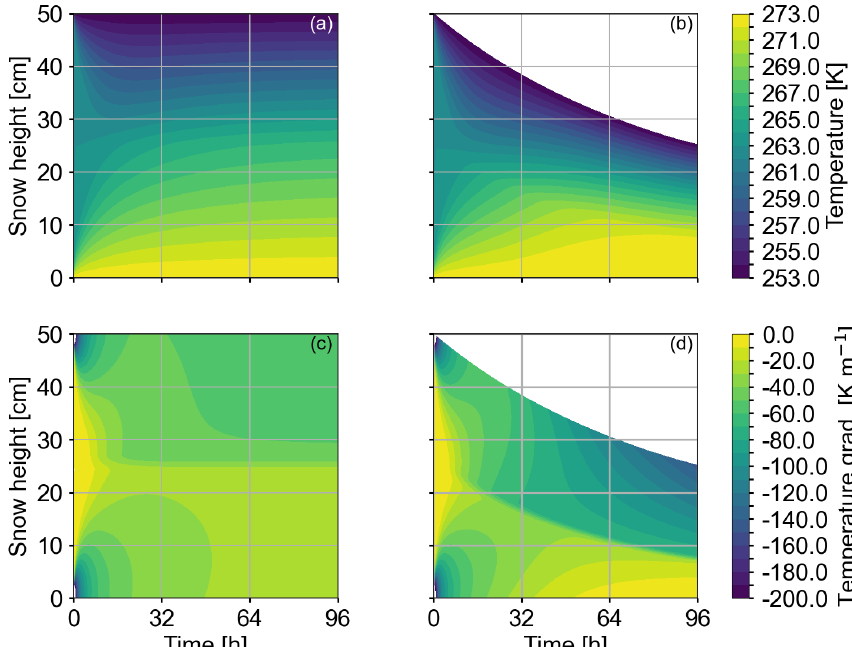
Figure 6. Panels (a) and (c) show the results for Case 2 of Table 2 corresponding to heat transport being solely active. Panels (b) and (d) show the results for Case 3 of Table 2 corresponding to active heat transport and mechanical settling. For each plot the y axis represents snow height and x axis time. The plots in the top row ( a , b ) show the temperature evolution, and the plots in the bottom row ( c , d ) show the respective temperature gradients. In (a) and (c) settling is inactive, so the boundary of upper layer and lower layer is at the snowpack center. In (b) and (d) , we interpret the upper, darker part, which is characterized by higher gradients, as the upper layer and the lower, lighter area with lower gradients as the lower layer. The initial conditions for both cases are equivalent (see Fig. 3). In Case 2 the temperature profile (a) has reaches the stationary, piecewise linear profile after approximately 60h. In Case 3 the temperature profile (b) is not yet stationary at the end of the simulation (96h) as mechanical processes are still yielding a change in the ice volume fraction. The temperature gradient (c) will become constant only when the maximum ice volume fraction has been